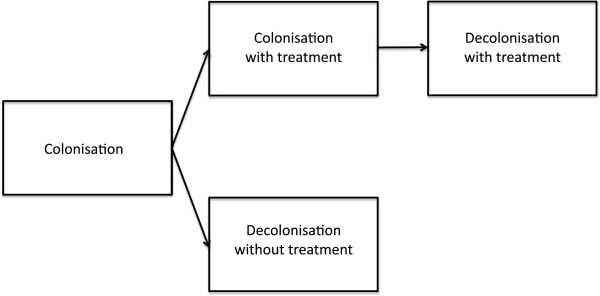
Multistate model. This multistate model was used for estimating the median time to decolonisation relative to the start of nebulised amphotericin B, and for graphically representing colonisation persistence probability curves in Figure 4. A patient with colonisation remained in this state as long as no treatment was given. Patients transitioned to the 'colonisation with treatment’ state upon receiving treatment, and subsequently transitioned to 'decolonisation with treatment’ state when decolonisation occurred. The patient underwent transition to 'decolonisation without treatment’ state in case decolonisation occurred without treatment or before treatment was started. Thus, two states were transitional states, whereas the remaining two states were final states in our model (meaning that no further data were included in the model beyond this point in time).